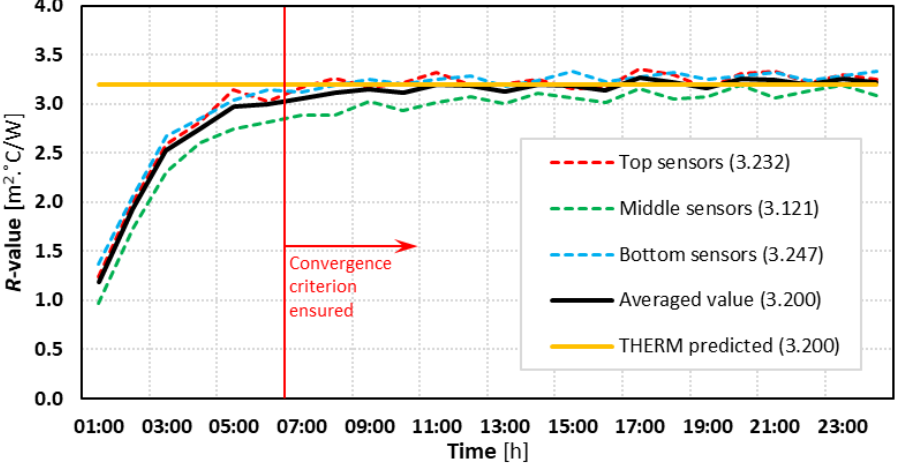
Figure 6. Estimated measured thermal resistances ’ variation over time, three different sensor heights ’ locations and the predicted THERM R -value for the reference LSF facade wall.